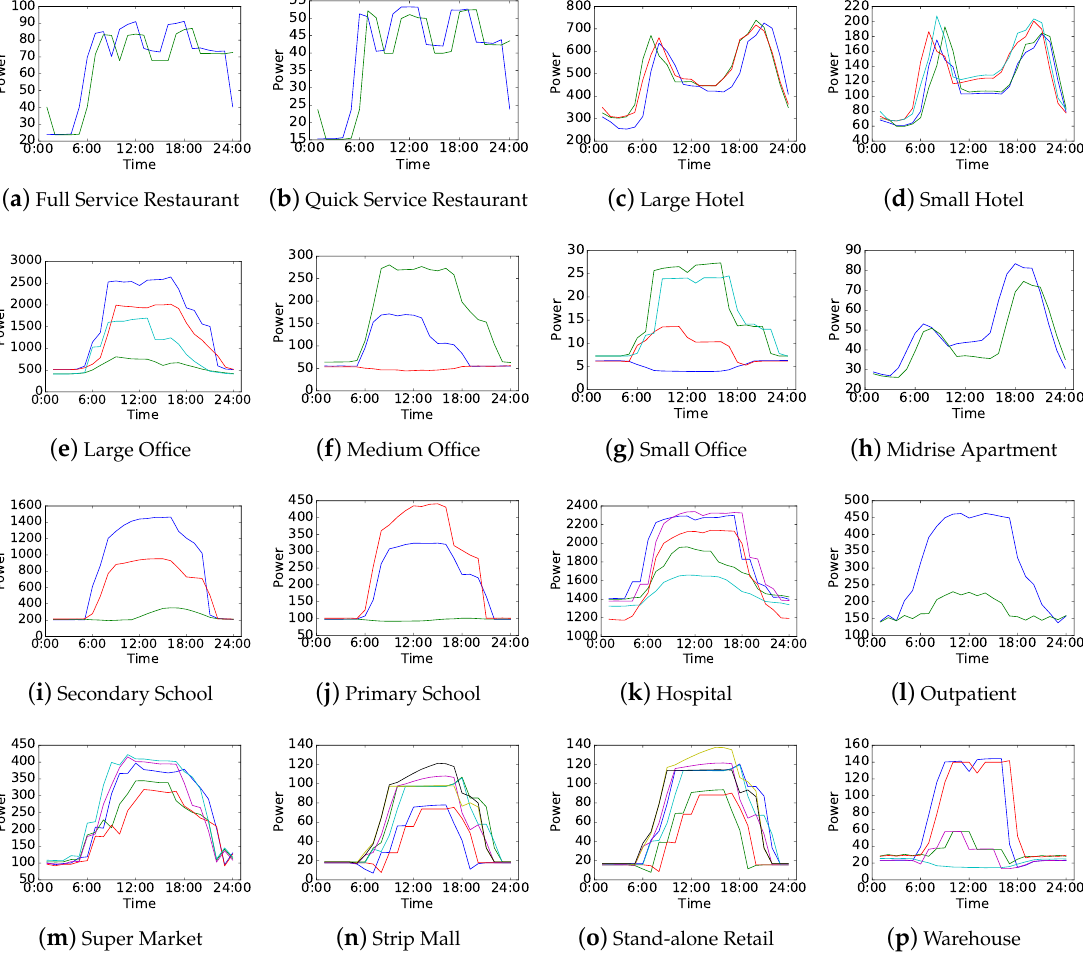
Figure 4. Sixteen examples of load patterns. Each subfigure denotes the load patterns of one electricity consumer referring to one consumer type (building type) in the dataset. The load patterns are obtained from one of ten experiments with 60% training